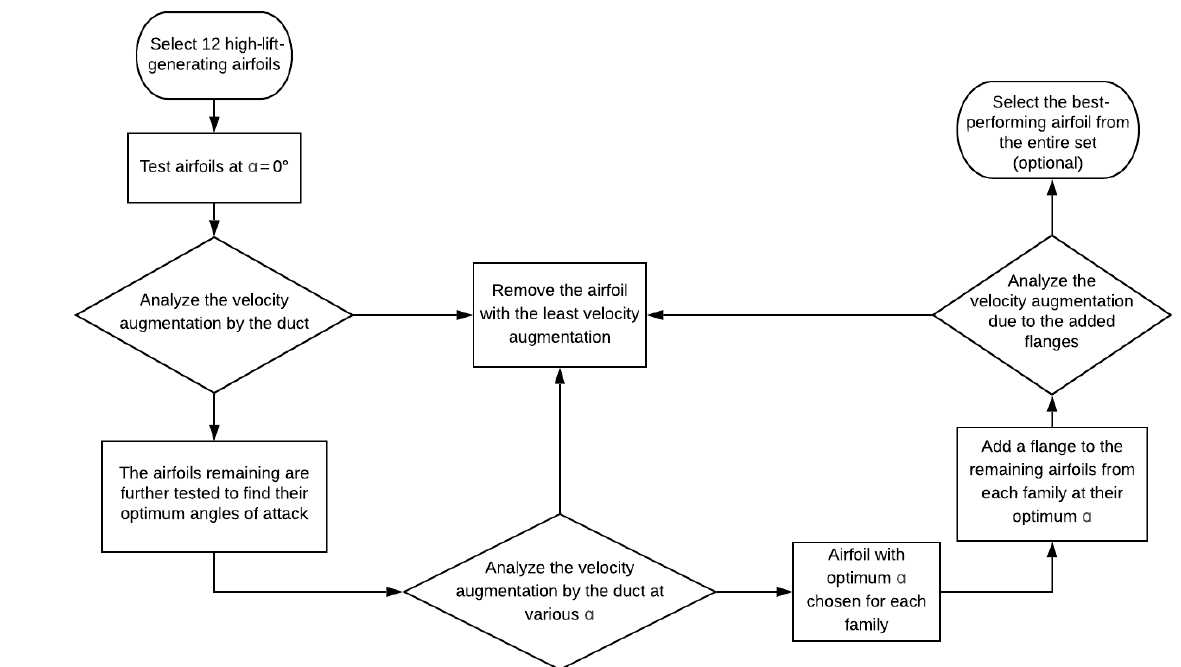
Figure 5. A flowchart that visualizes the simulation methodology and processes.